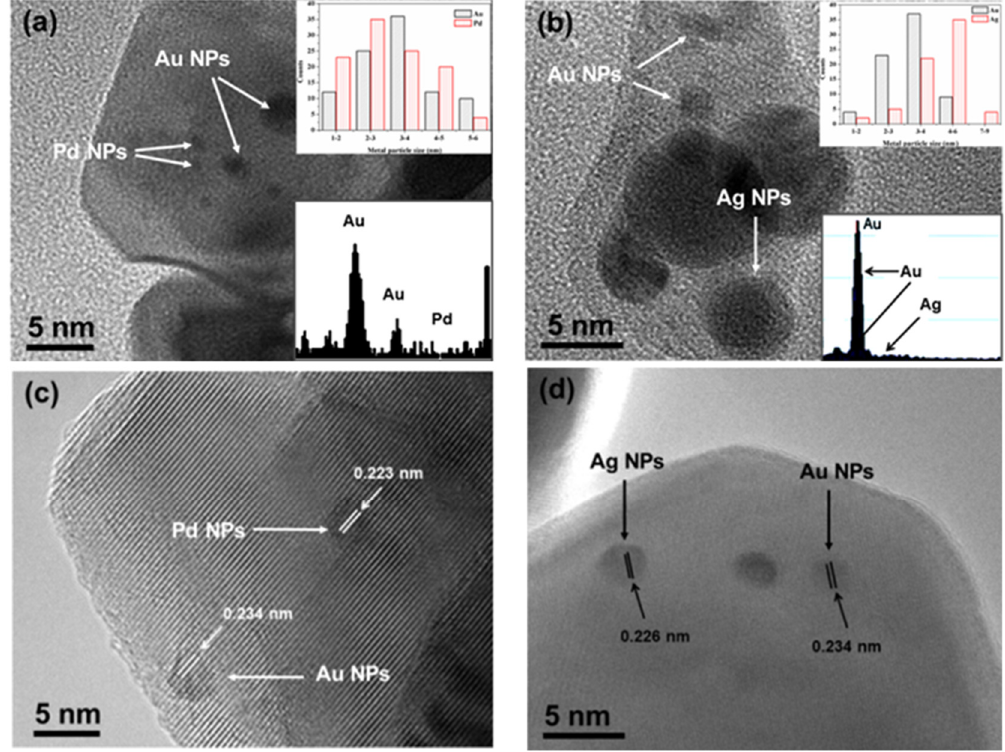
Figure 11. TEM (Transmission electron microscopy) ( a : Au ‐ Pd and b : Au ‐ Ag) and HR ‐ TEM ( c : Au ‐ Pd and d : Au ‐ Ag) images of Au ‐ Pd and Au ‐ Ag catalysts supported on TiO 2 (anatase). EDX (energy ‐ dispersive X ‐ ray) spectra belong to AuPd/TiO 2 (inset a ) and AuAg/TiO 2 (inset b ) catalysts. Histograms show particle size of AuPd (inset a ) and AuAg (inset b ) supported on TiO 2 [84].